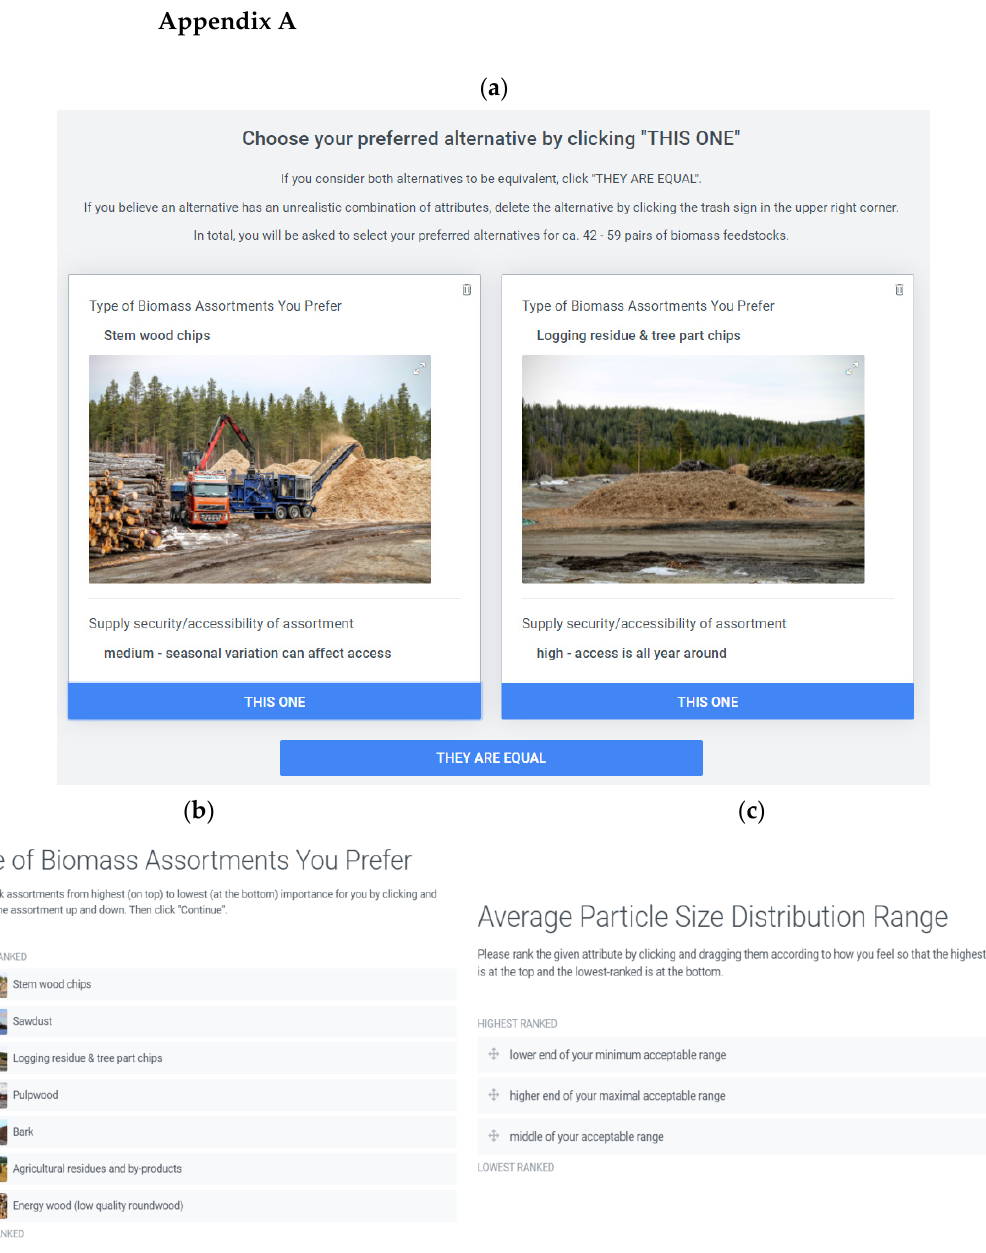
Figure A1. Examples of the layout and question formats included in the survey. Sets of alternative responses were presented to the participants, in pairwise format ( a ) or to be ranked ( b , c ) according to preference. Table A1. Country of origin, biomass conversion technology, and facility capacity, as represented by the respondents to the preference survey ( n = 20).